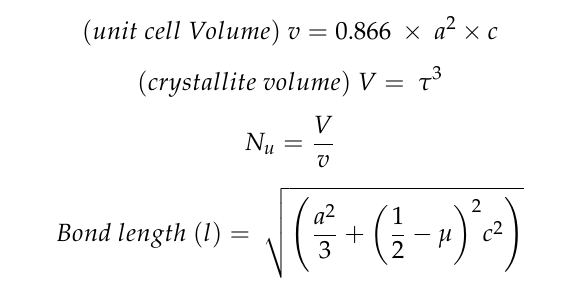
Figure 2. 2 × 2 × 2 supercell structure of V-doped ZnO using WIEN2K shown in z-x plane, y-z plane, and 3D (zinc atoms: green, vanadium atoms: purple, oxygen atoms: maroon). These relations are used to find the unit cell volume ( v ) , crystallite volume ( V ), and unit cells per crystallite ( N u